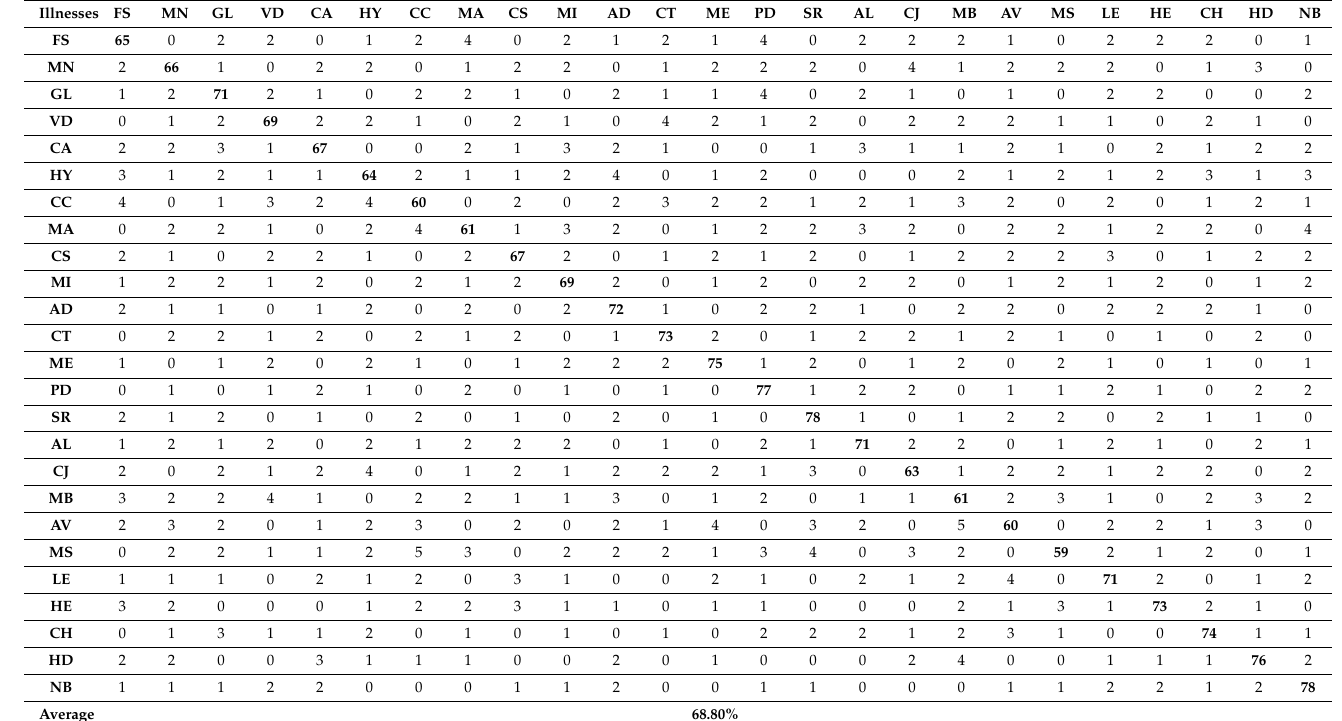
Table 5. Performance of Latent Semantic Analysis method (instead of using the developed approach) using MRI dataset (Unit